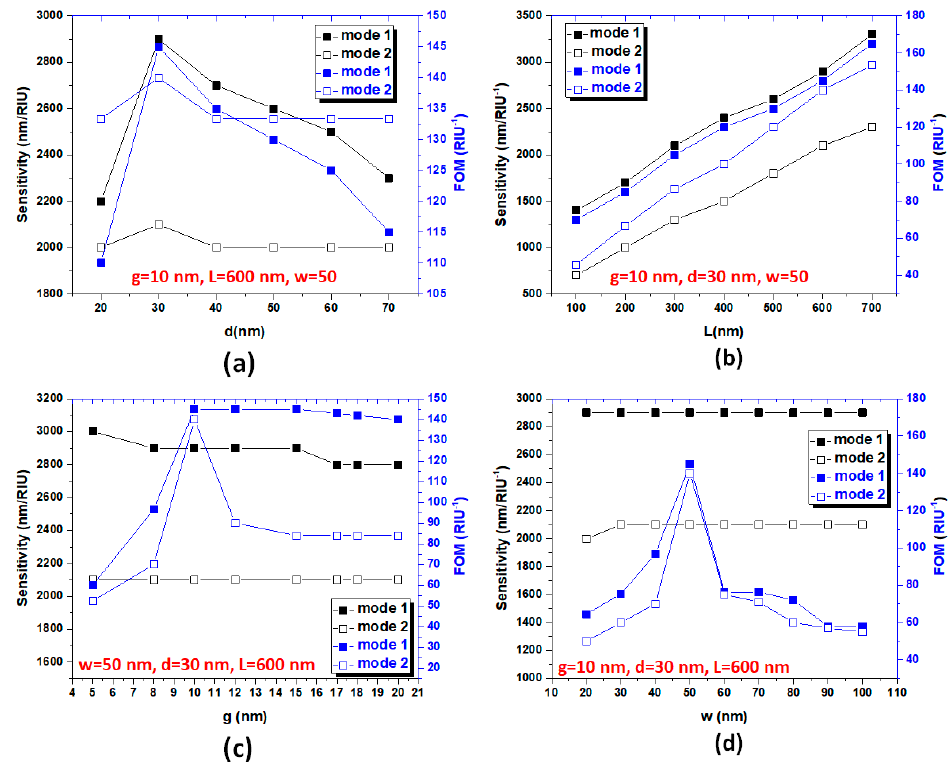
Figure 7. Sensitivities and figure of merit (FOM) of the proposed plasmonic sensor with Ag baffles in mode 1 and mode 2 for varying ( a ) vertical coupling distance ( d ) from 10 to 70 nm in the step of 10 nm, ( b ) varying Ag buffalo length ( L ) from 300 to 700 nm in the step of 100 nm, ( c ) varying coupling distance ( g ) in the range of 5–20 nm, and ( d ) varying the straight waveguide width (w) from 20 to 100 nm in the step of 10 nm, correspondingly. The other structural parameters are indicated in the inset of the figures.